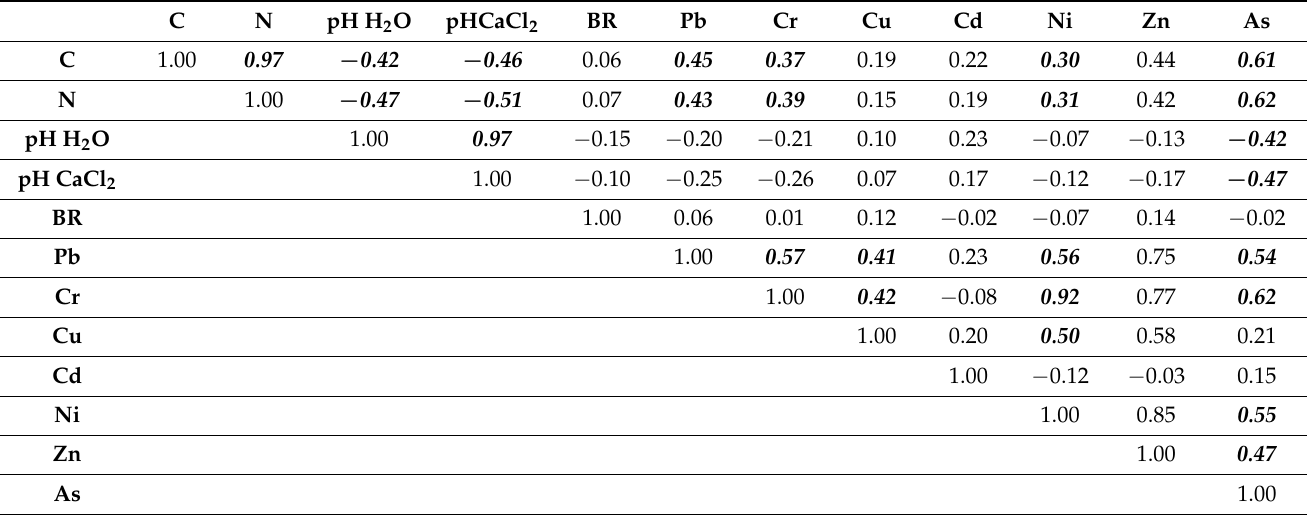
Table 6. Spearman rank order